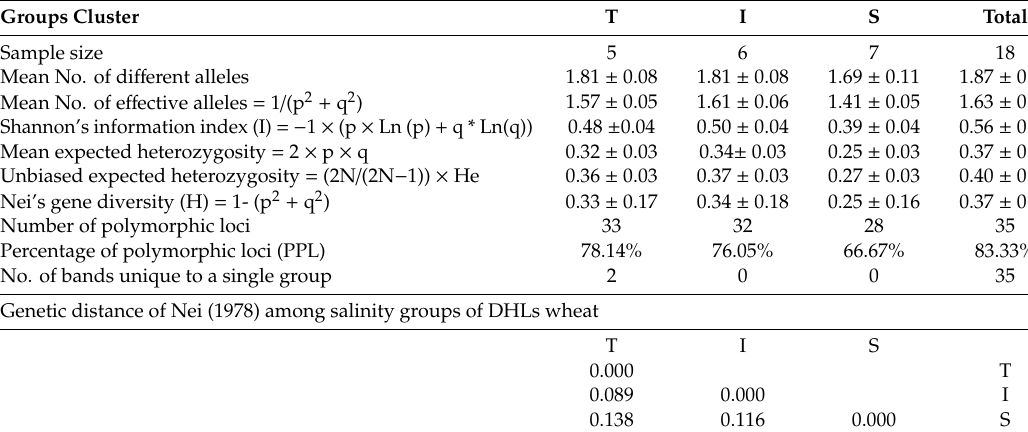
Table 6. Intra-groups diversity measures of wheat genotypes based on SSR